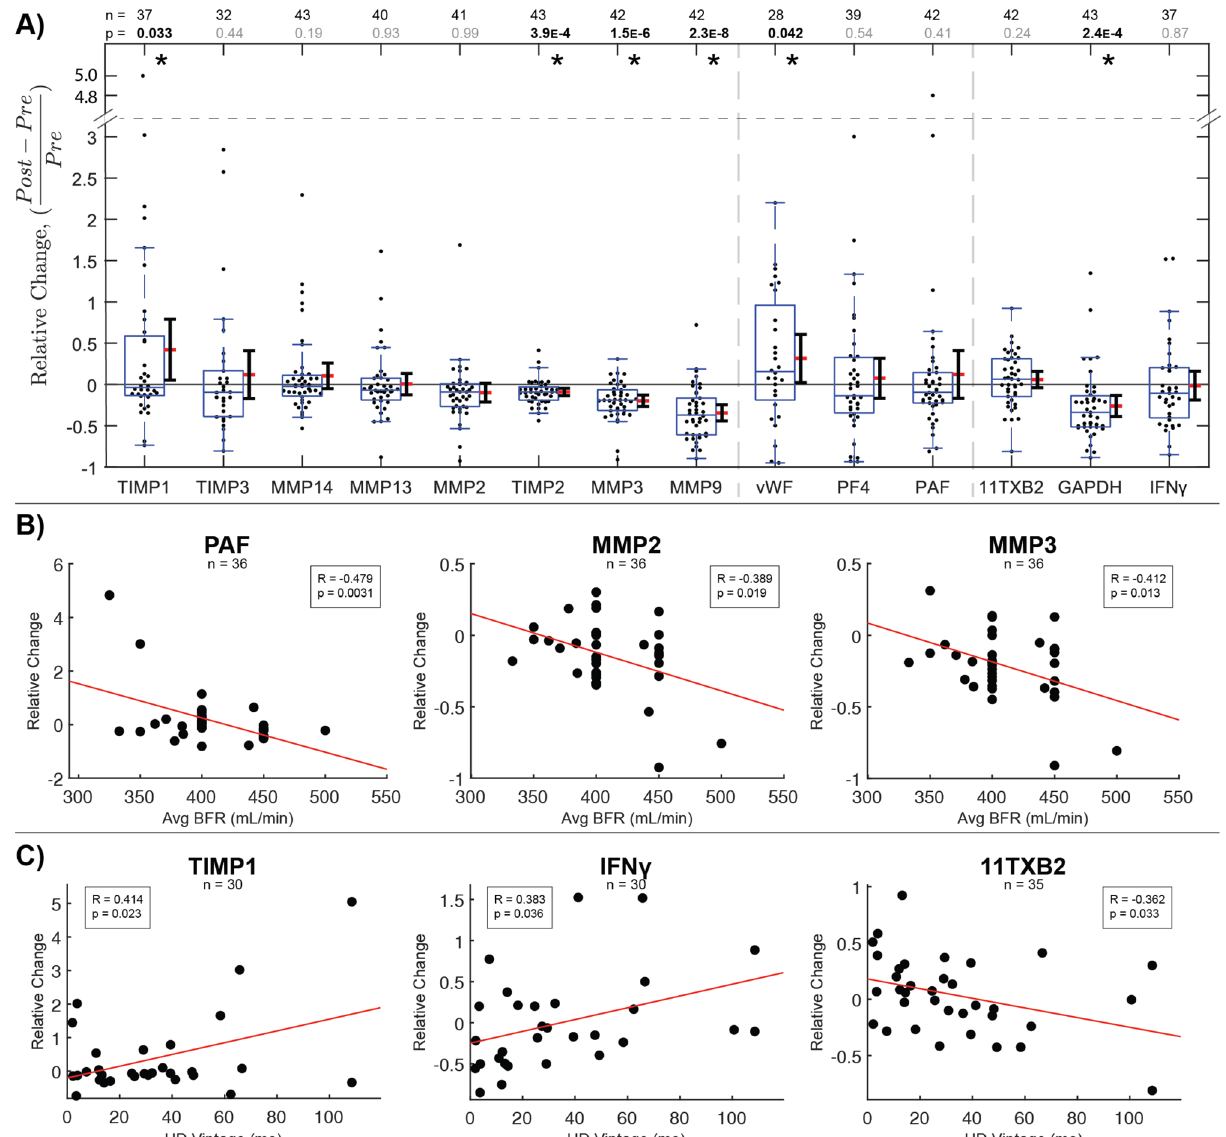
Figure 2. Intra-dialysis changes reveal MMP clearance and acute TIMP1 elevation that increases in severity with dialysis vintage. ( A ) Relative changes in paired plasma samples from dialysis patients pre- and post- treatment as measured by ELISA. Significant intra-dialysis increases were observed in proteolytic regulator TIMP1 and clotting factor vWF. Significant decreases were observed in TIMP2, proteases MMP3 and MMP9, and oxidative stress indicator GAPDH. Statistical significance was assessed using one-sample t test. * p < 0.05. Box and whisker plots represent quartiles. Adjacent ranges represent mean (red) ± 95% confidence interval. ( B and C ) Significant Pearson correlations ( p < 0.05) between intra-dialysis plasma protein changes and BFR or Vintage, respectively. Negative relationships against PAF and MMPs show clearance with increasing BFR. Positive relationships against TIMP1 and cytokine IFNγ support increasing proteolytic inhibition and immune reactivity with Vintage, while decreasing thromboxane metabolite with Vintage reflects progression of coagulative dysfunction. Figure was prepared in Matlab R2019 (Mathworks, Nattick MA, www. mathw orks.